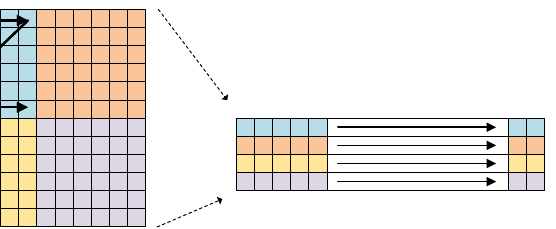
Figure 12. Parameter reordering. According to loop tilling, only a small share of input map is introduced. Thus, the sequence of the feature map can be reorganized to speed the process of memory